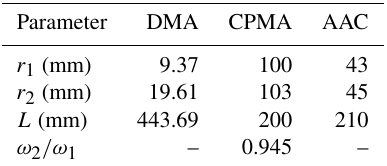
Table 1. Dimensions of the three classifiers used for transfer func- tion